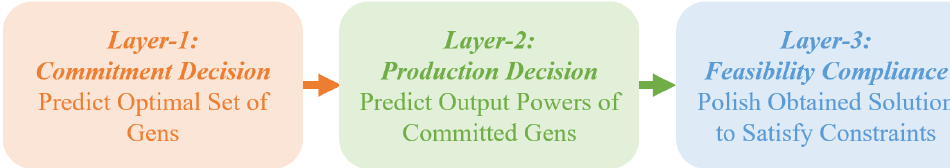
Figure 3. The Proposed Multi-Layer SCUC Algorithm.